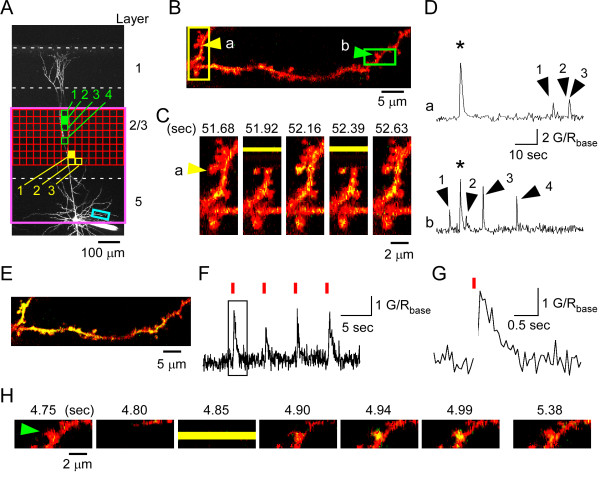
Induction of Ca2+ transients in the dendritic spines of a layer 5 cell by 2pMAPG mapping in layer 2/3. (A) A Z-stacked image of a representative layer 5 pyramidal cell filled with Alexa Fluor 594. White broken lines indicate laminar borders. The depth of the soma was 53 μm from the slice surface. The red boxes indicate the 2pMAPG mapping area. The sky-blue rectangle indicates the Ca2+ imaging region. The purple box indicates the field of view under the 25× objective lens. (B) Ca2+ imaging region corresponding to the sky-blue rectangle in (A). Red (Alexa Fluor 594) fluorescence and green (Fluo-5F) fluorescence are overlaid. The time interval between images was 236 ms. Dendritic spines indicated by yellow (a) and green (b) arrows exhibited Ca2+ transients after 2pMAPG at the yellow and green pixels in (A), respectively. (C) Five sequential images from the yellow-boxed region in (B). Numbers at the top of the image indicate the onset time of each imaging frame relative to that of the first imaging frame. The yellow horizontal bar in the second frame indicates the time of 2pMAPG at solid yellow pixel 1 in (A). (D) G/R traces in spines shown by the arrows marked a and b in (B) are shown at the top and bottom, respectively. Traces were obtained during 2pMAPG mapping at a depth of 130 μm. Arrows indicate Ca2+ transients immediately after 2pMAPG at the yellow and green pixels in (A). The numbered arrows correspond to the numbered pixels in (A) and the spines shown in (B). Asterisks indicate Ca2+ transients observed throughout the dendrite, possibly due to bursting activity. (E) The image at the time corresponding to the asterisk in (D). (F) The G/R trace in the spine indicated by the green arrow in (B) was obtained by fast imaging of the green-boxed region in (B). The time interval between images was 48 ms. During imaging, 2pMAPG was performed at the green closed pixels in (A) at 0.2 Hz (red bars). (G) Expanded G/R trace boxed in (F). (H) Seven images before, during, and after 2pMAPG in (G).